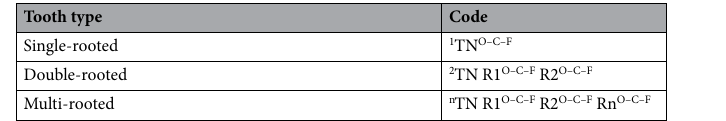
Table 1. Ahmed’s criteria coding assigned to single, double, or multiple root teeth. C canal; F foramen; n, refers to three or more roots; O orifice; R root; TN tooth number.